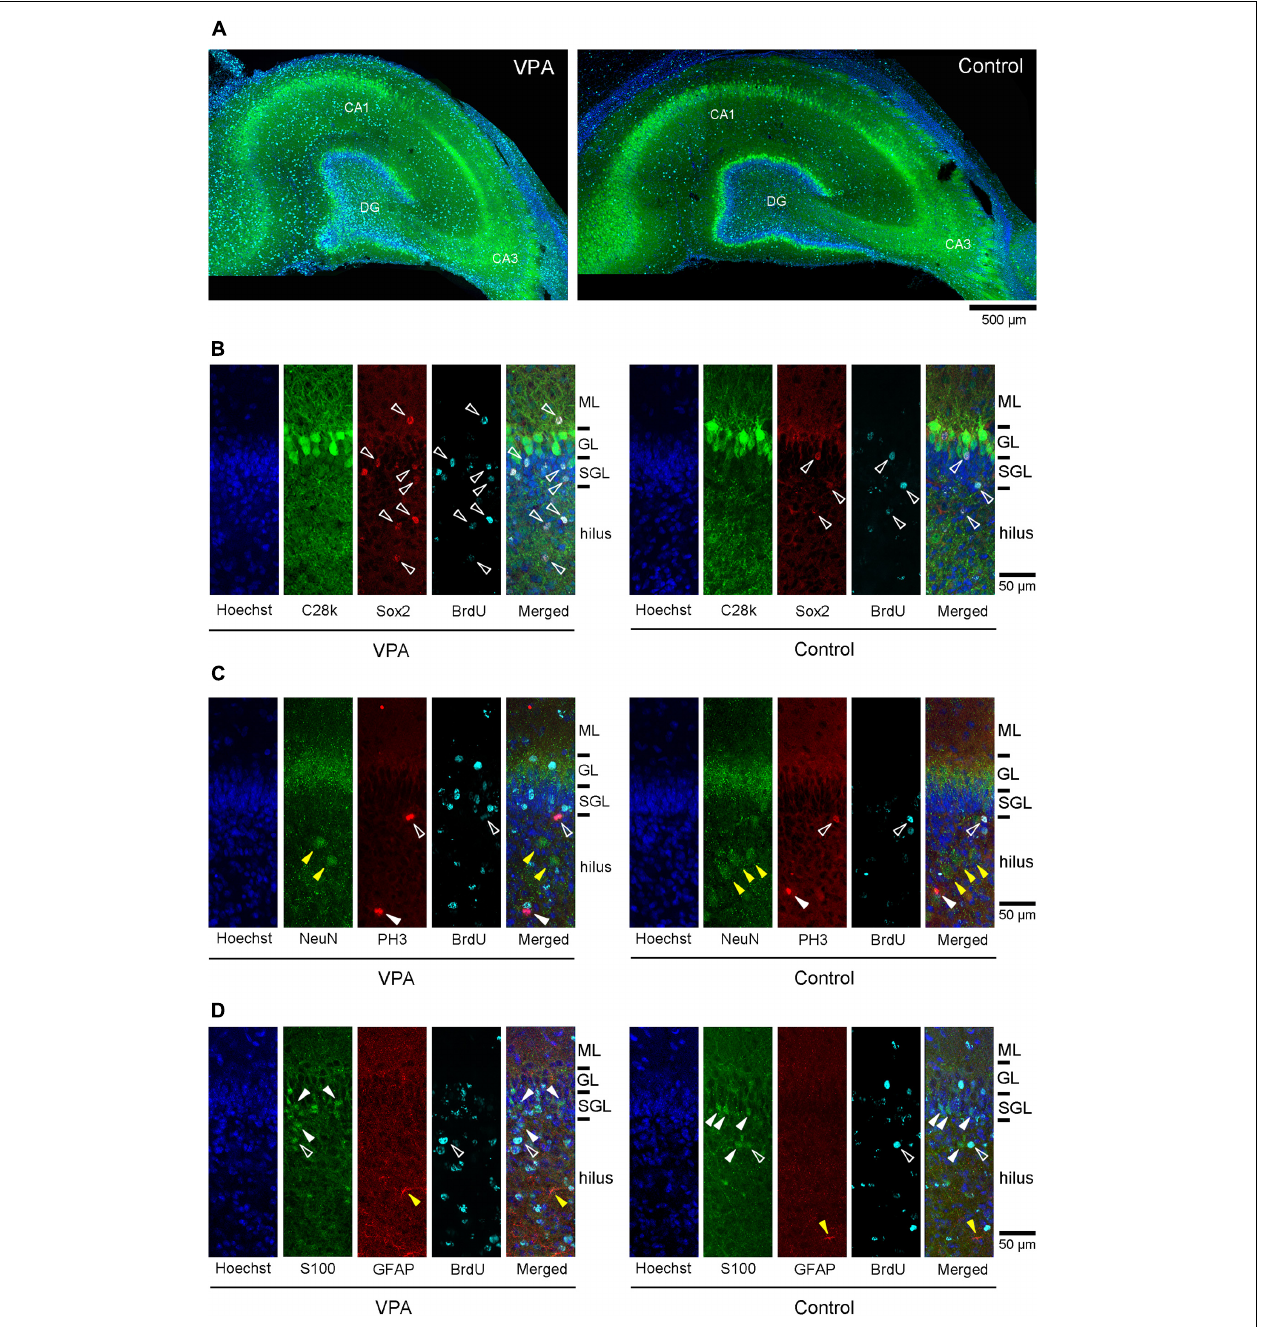
FIGURE 2 | Immunofluorescence images for antibodies against various marker antigens with 5-bromo-2-deoxyuridine (BrdU)-labeling and Hoechst staining in dorsal hippocampi of postnatal day (PD) 20 ferrets. (A) Low-magnification images of calbindin D-28k immunofluorescence with BrdU-labeling and Hoechst staining in the dorsal hippocampus at the coronal plane including the caudal end of the splenium of the corpus callosum in valproic acid (VPA)-treated (left) and control (right) ferrets. (B) High magnification images of double immunofluorescence for calbindin D-28k and Sox2 with BrdU-labeling and Hoechst staining in the dentate gyrus of the dorsal hippocampus in VPA-treated (left) and control (right) ferrets. White open arrowheads indicate BrdU-labeled Sox2-immunopositive progenitors located in the molecular layer (ML), subgranular layer (SGL), and hilus. (C) High-magnification images of double immunofluorescence for NeuN and PH3 with BrdU-labeling and Hoechst staining in the dentate gyrus of the dorsal hippocampus in VPA-treated (left) and control (right) ferrets. White open arrowheads indicate BrdU-labeled PH3-immunopositive cells. White closed arrowheads indicate PH3-single stained cells. Yellow closed arrowheads indicate NeuN-single stained neurons in the hilus. (D) High-magnification images of double immunofluorescence for S100 and glial fibrillary acidic protein (GFAP) with BrdU-labeling and Hoechst staining in the dentate gyrus of the dorsal hippocampus in VPA-treated (left) and control (right) ferrets. White open arrowheads indicate BrdU-labeled S100-immunopositive cells. White closed arrowheads indicate S100-single stained neurons in the SGL and hilus Yellow closed arrowheads indicate GFAP-single stained astrocytes in the hilus.